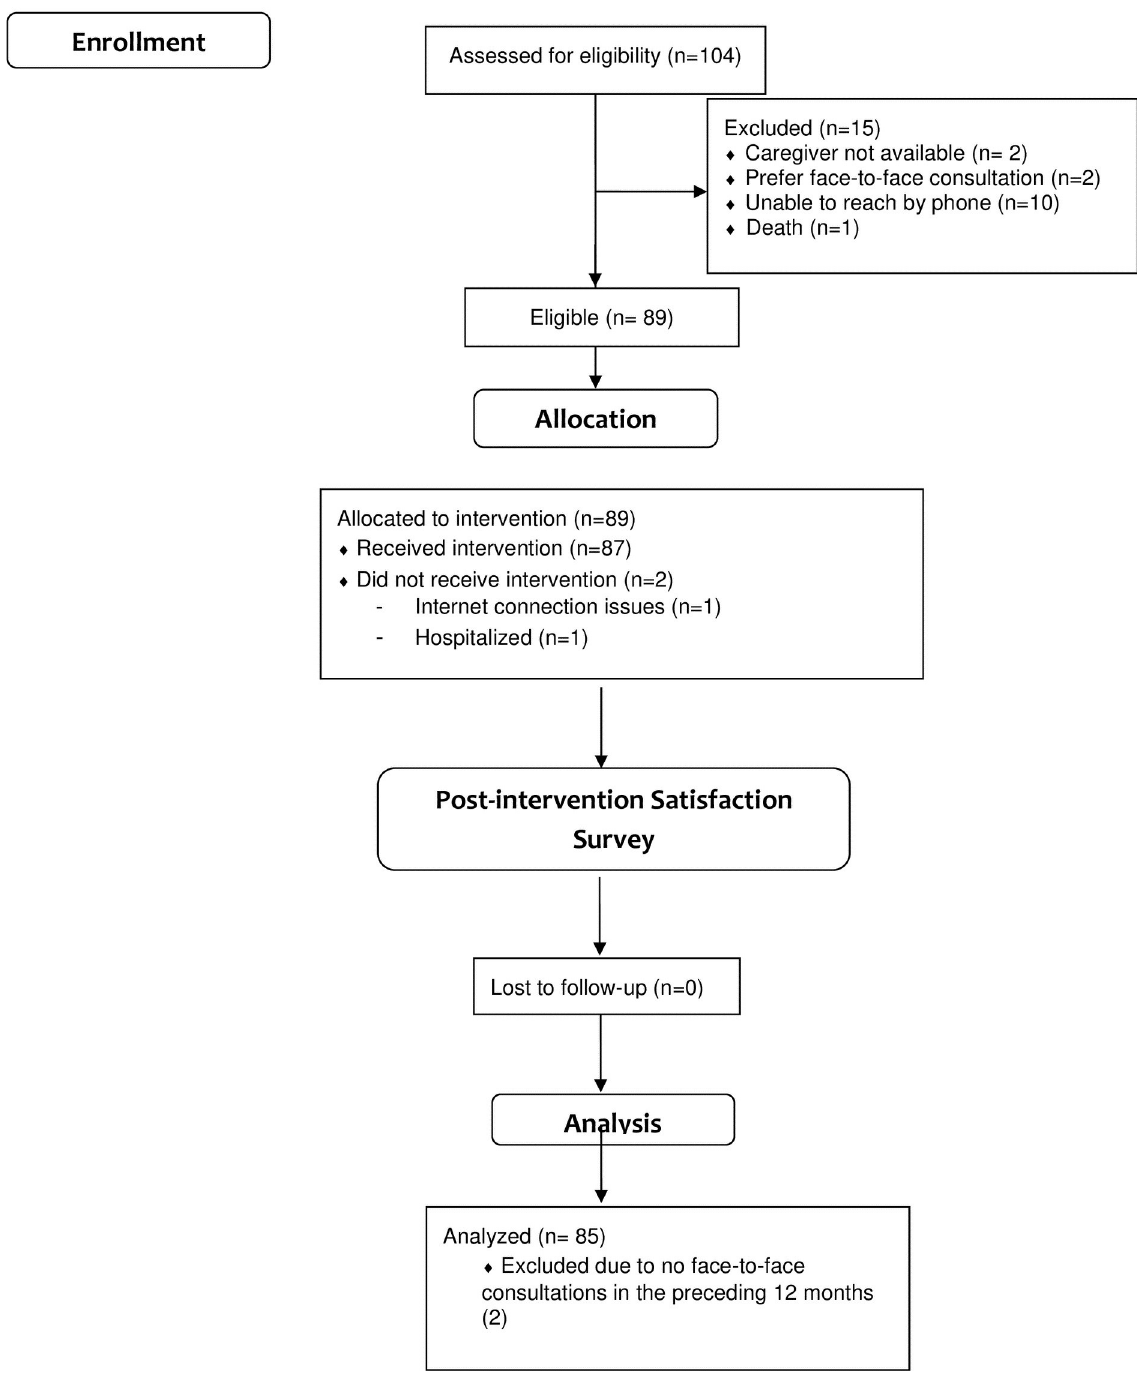
Fig 1. CONSORT 2010